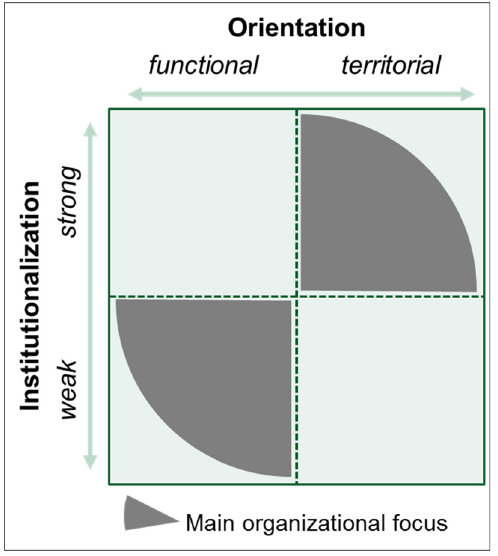
Figure 6. Balancing strong and weak formalization in cross-border governance. Source: Authors’ own